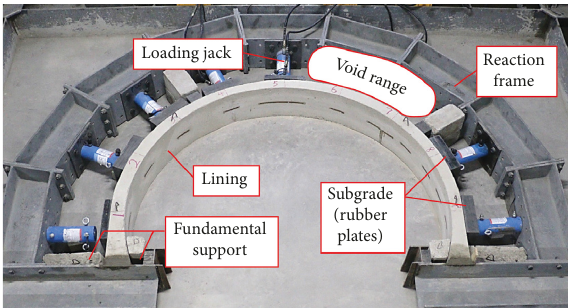
Figure 2: Field test picture.